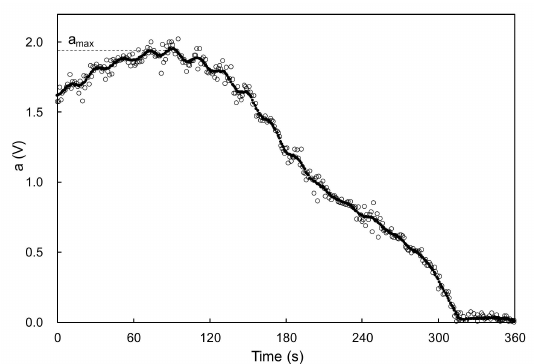
Figure 4. Example of time dependence of detected voltage.